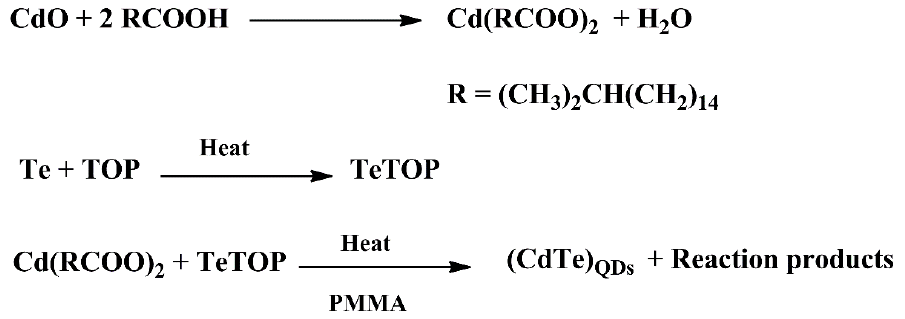
Scheme 1. Scheme of the synthesis of the cadmium isostearate, trioctylphosphine telluride and the CdTe quantum dots